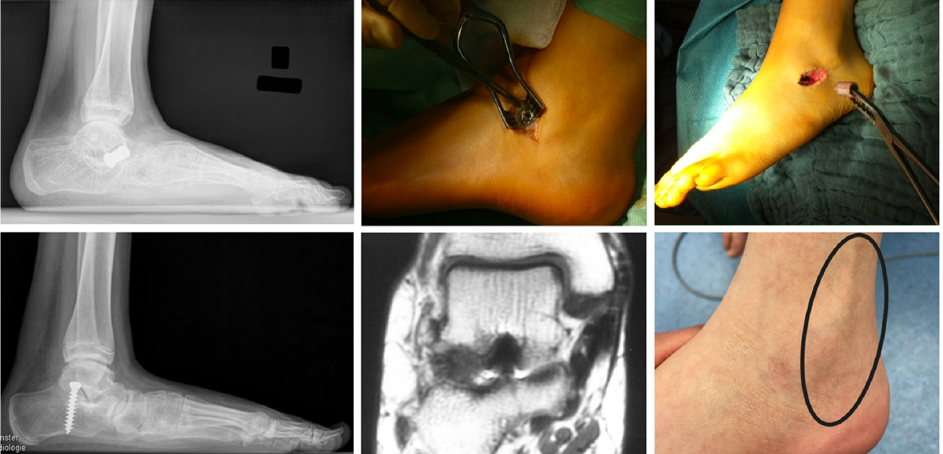
Figure 9. Treatment-related complications. Secondary dislocation of a Kalix ® endorthesis depicted on lateral radiograph showing the dislocated implant and recurrent deformity ( top – left ) and intraoperative situation during premature removal surgery ( top – center , right ). Primary malposition of a subtalar extra-articular screw arthroereises (SESA) depicted on lateral radiograph showing the wrong screw position and recurrent deformity ( bottom – left ). Secondary breakage of a Giannini implant depicted on a coronar magnetic resonance imaging scan ( bottom – center ). Clinical presentation of a reactive peroneal muscle contracture after SESA ( bottom – right